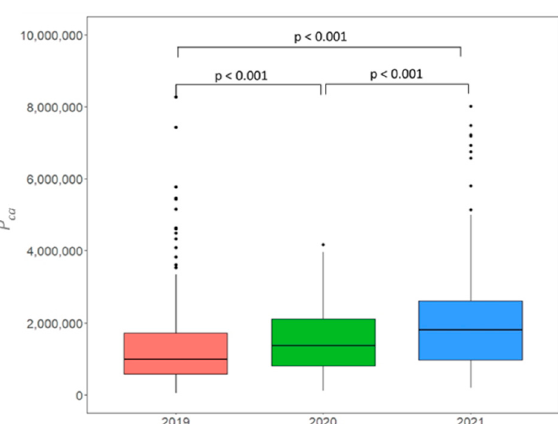
The number of catkins in a crown sampling unit ( C su ; 0.125 m 3 ) ranged between 3 and 120 with an average of 29 catkins. C su in 2020 were 191% and 232% higher compared to 2019 and 2021 and 17% lower in 2021 compared to 2019. Statistics for all analyzed levels ( P ca , P fl , P cr , fl and C su ) are presented in the Appendix A (Table A1). We detected a statistically significant difference between P ca among the three study years (H (2) = 46.29, p < 0.001). A post-hoc test revealed that there were significant differ- ences between all pairs of years (Figure 2). The same applied for C su (H (2) = 200.78, p < 0.001; boxplots not shown).